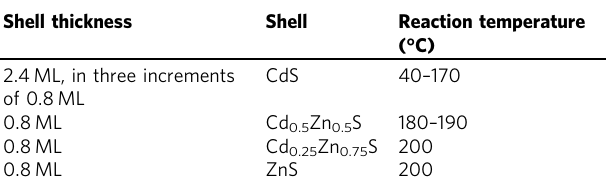
Table 1 Shell growth conditions for